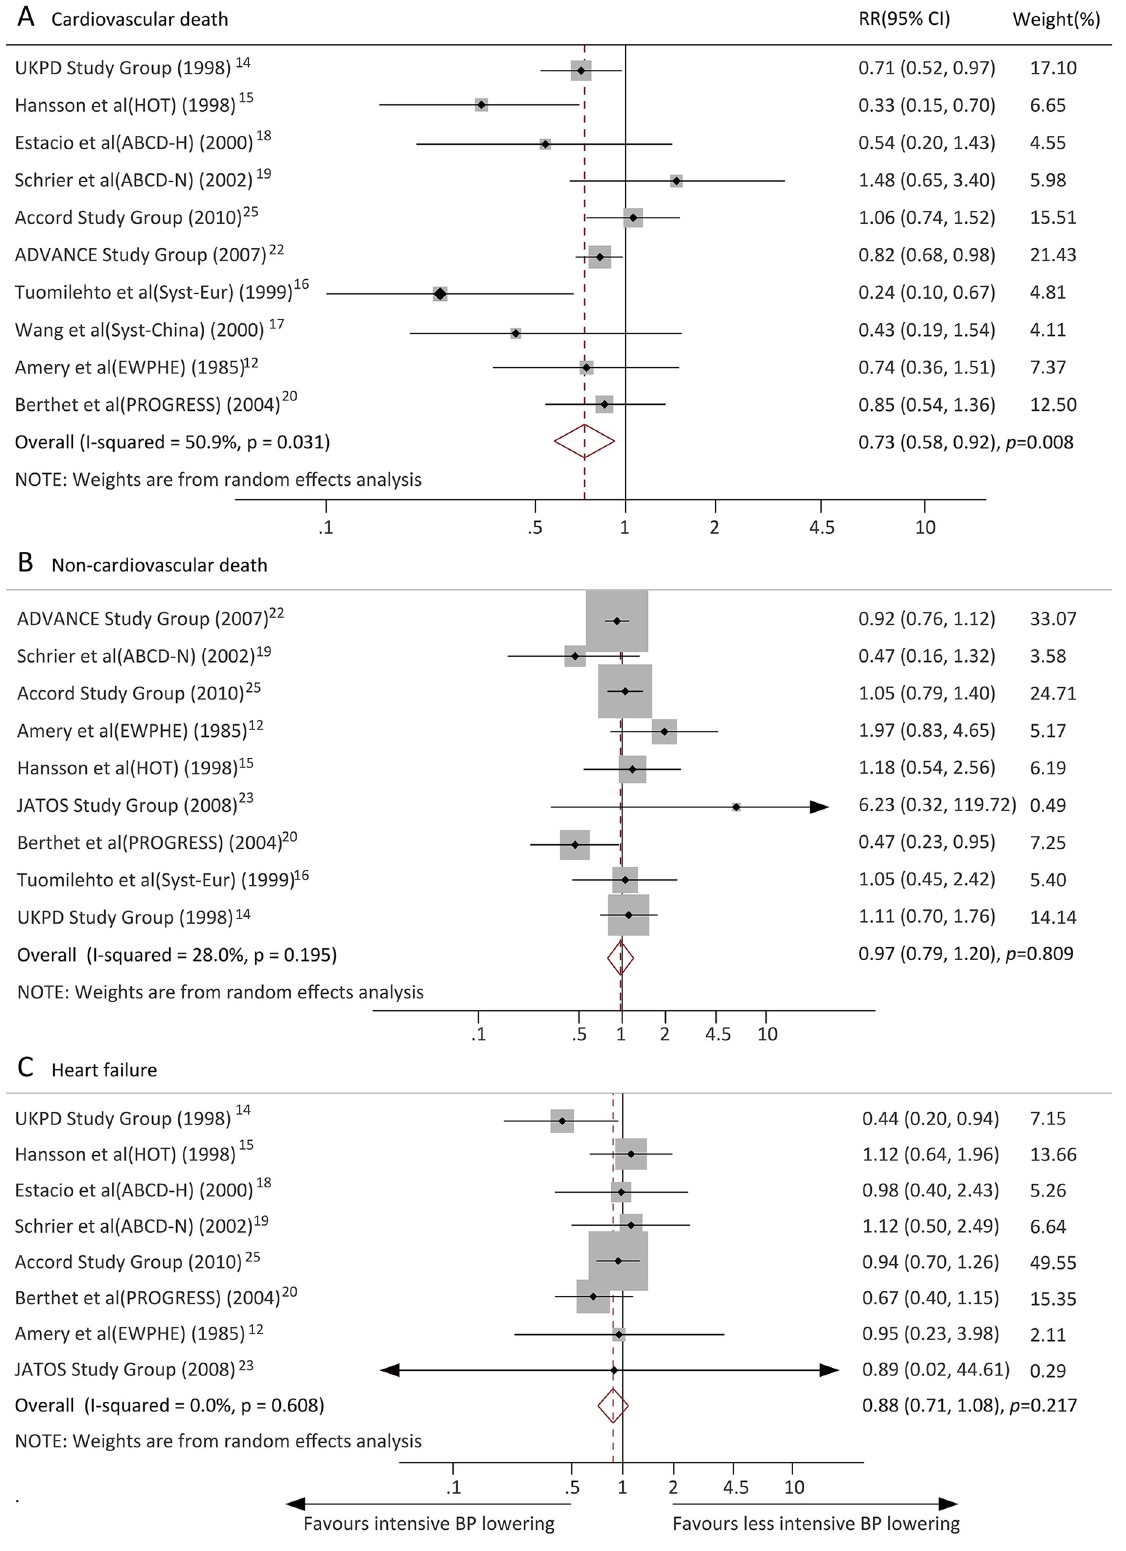
Fig 4. Effects of intensive blood pressure lowering on risk of cardiovascular outcomes (A) Cardiovascular death; (B) Non-cardiovascular death; (C) Heart failure. https://doi.org/10.1371/journal.pone.0215362.g004 PLOS ONE | https://doi.org/10.1371/journal.pone.0215362 April 12,